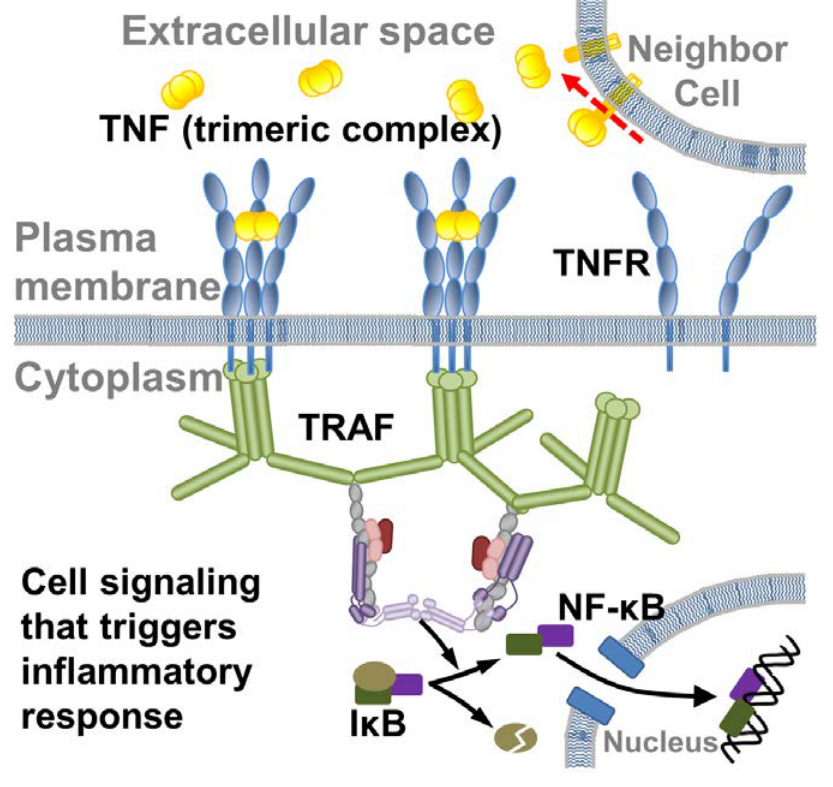
Figure 1. Ligands that belong to tumor necrosis factor (TNF) superfamily are originally expressed on cell surfaces. Most of them are oligomerized into trimers and later cleaved by metalloproteases. On cell plasma membrane, the binding between TNF ligands and their receptors in the tumor necrosis factor receptor (TNFR) superfamily initiates multiple intracellular signaling pathways. For instance, the cytoplasmic region of TNFR after ligand binding will recruit the scaffold protein called TNF receptor associated factor (TRAF), which will further turn on the NF- κB signaling pathway. NF - κB is an important transcription factor in inflammation as an activator of numerous pro-inflammatory cytokines and chemokines. The red dashed arrow in the figure indicates the cleavage of TNF ligands into their soluble forms, while the black arrows illustrate the downstream signaling pathways activated by TNF ligand-receptor interactions.